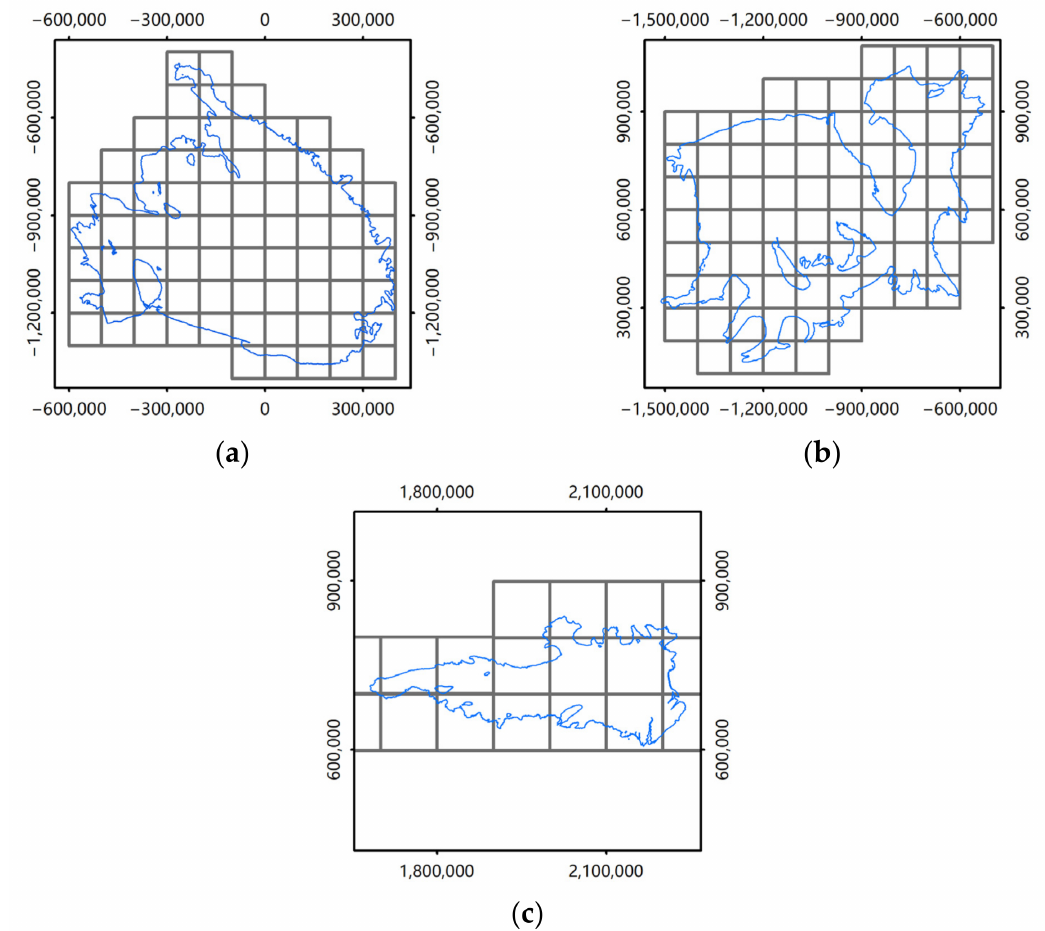
Figure 4. The 100 km by 100 km tiles of RIS, FRIS, and AIS DEMs. Maps are in the polar stereographic projection in meters. The small grey box in the diagram ( a – c ) represents the tile of